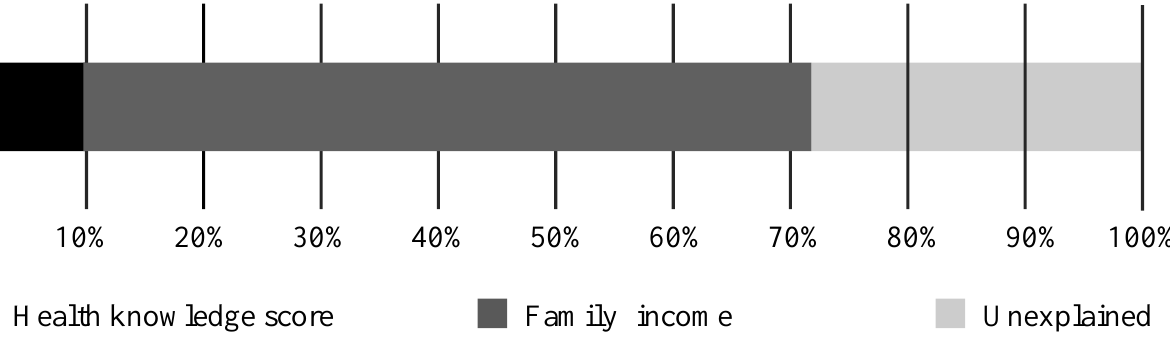
Figure 3. Decomposition of Mechanism.